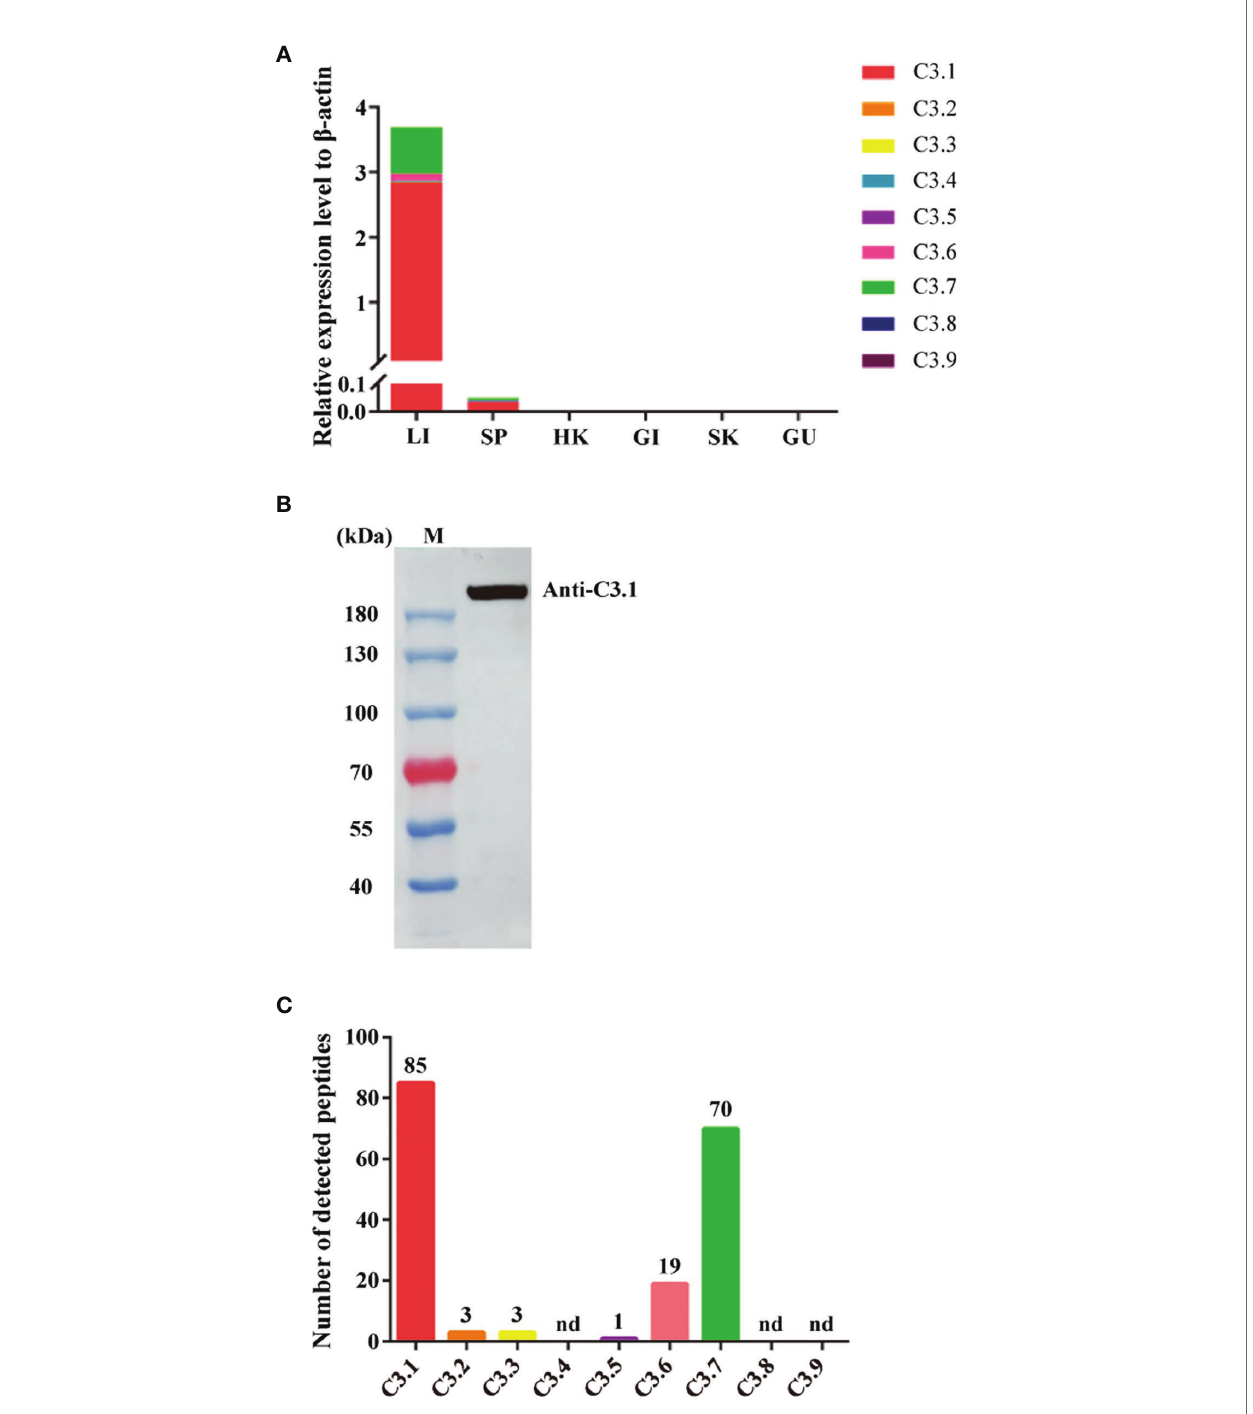
FIGURE 2 | Expression patterns of the nine C3 genes of grass carp at mRNA and protein levels. (A) Tissue expression patterns of the nine C3 genes of grass carp at the mRNA level. The expression levels were analyzed by qPCR and normalized against the expression of b -actin using the 2 − D Ct method. Abbreviations for tissues are as follows: LI, liver; SP, spleen; HK, head kidney; GI, gill; SK, skin; GU, gut. Data present the mean value of 5 fi sh. (B) Detection of C3.1 in grass carp serum by Western blotting. The grass carp serum was separated by gel fi ltration chromatography, and the fraction with molecular masses of 180-200 kDa was collected to detect C3.1 by Western blotting. M, marker (Thermo). (C) Expression patterns of the nine C3 molecules in grass carp serum. The gel slice corresponding to the C3.1 band in (B) was subjected to in-gel tryptic digestion, followed by LC-MS/MS analysis. The data shown are the copy numbers of the detected peptides from grass carp C3 molecules. nd, not